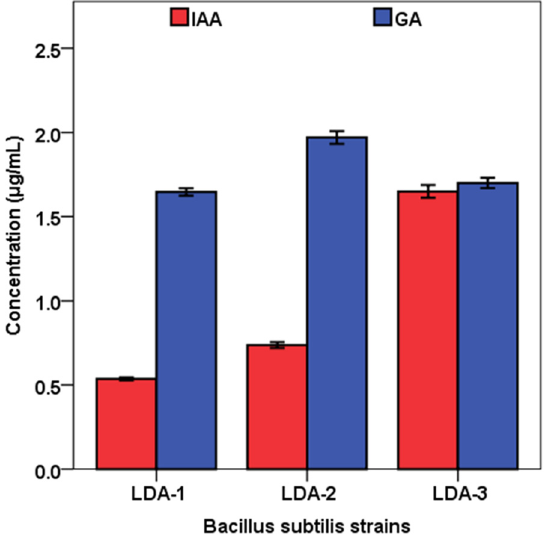
Figure 3. Indole acetic acid (IAA) and gibberellic acid (GA 3 ) produced by Bacillus subtilis strains LDA-1, LDA-2, and LDA-3. Values = mean ± SE, (n =